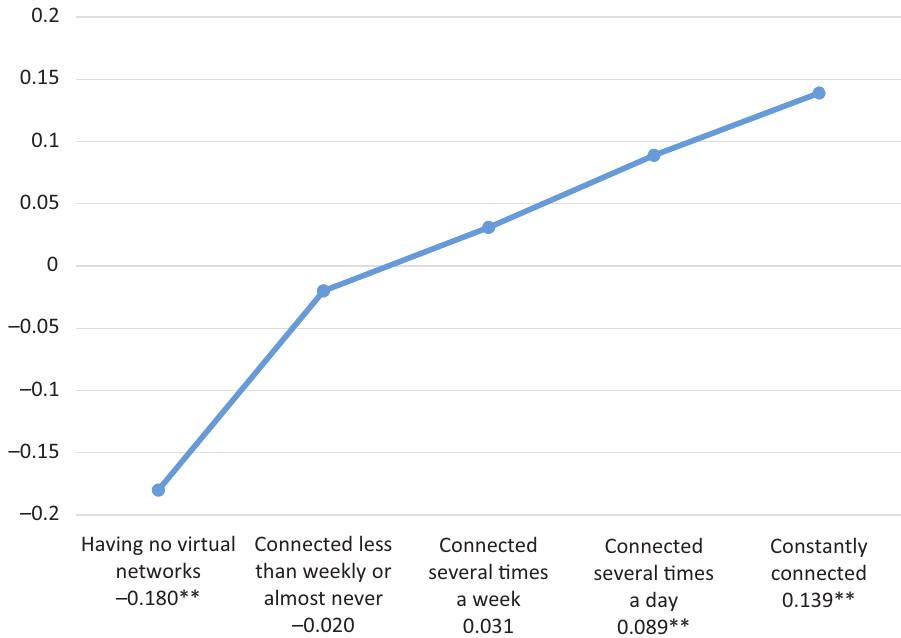
Figure 1. Correlation coefficients for the frequency of connection to digital networks and happiness. Level of significance: **0.01 (two‐tailed), *0.05 (two‐tailed). Source: Authors’ own, calculated from Barometer 3038 (Sept. 2014) and 3128 (Feb. 2016) from CIS (2014, 2016).